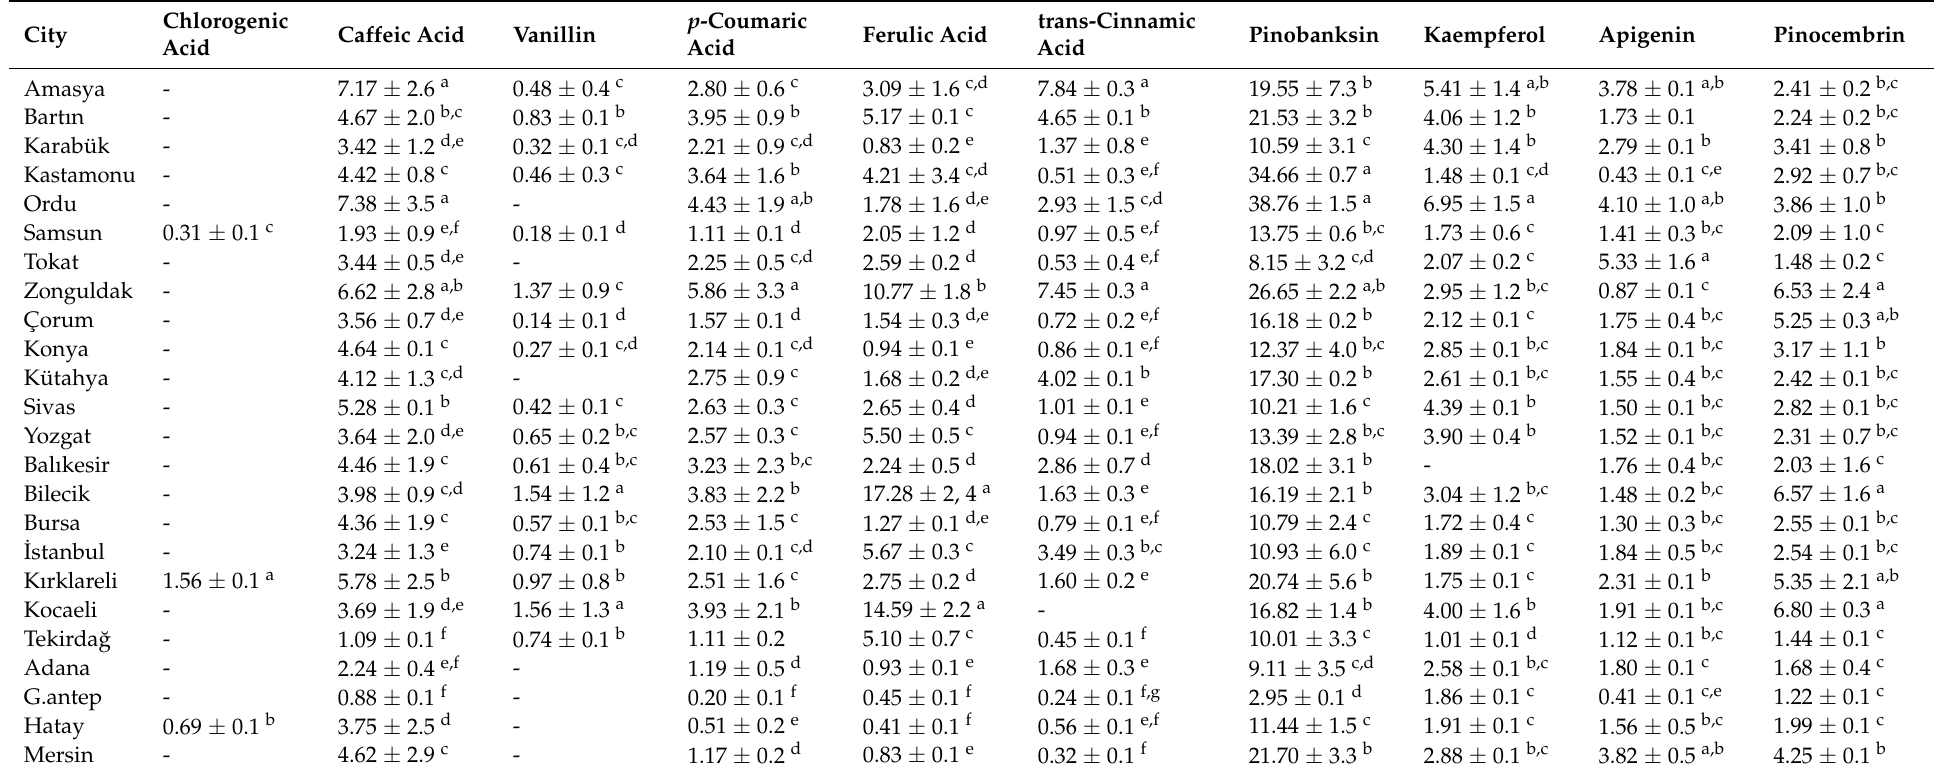
Table 3. Content of individual compounds (phenolic acids, phenolic aldehyde, and flavonoids) determined in Anatolian propolis samples (data are expressed as mg/g of the crude propolis